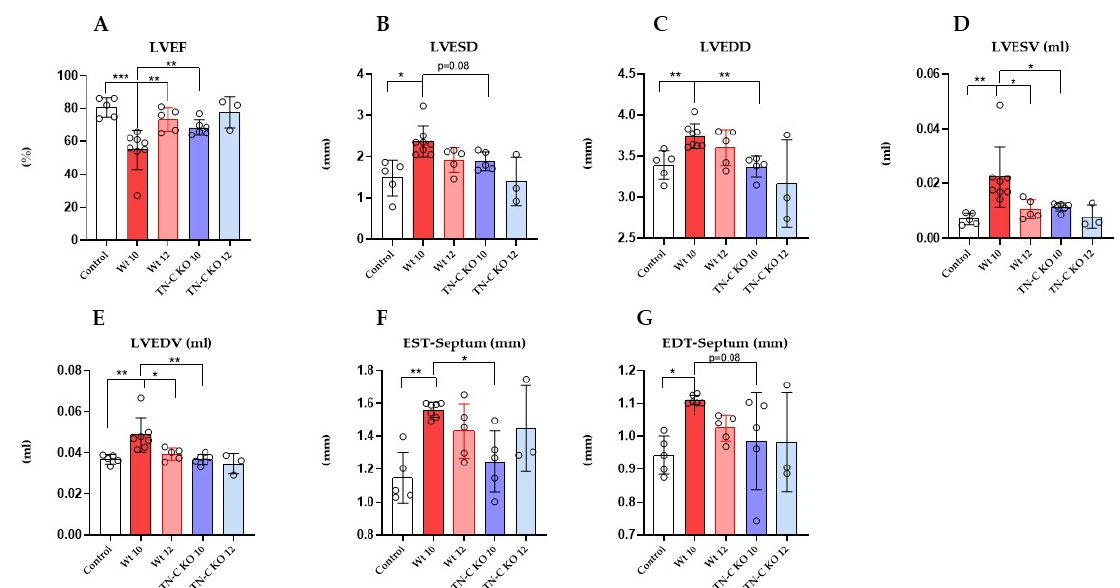
Figure 2. ( A ) Left ventricular ejection fraction (LVEF). ( B ) Left ventricular end-systolic dimension (LVESD). ( C ) Left ventricular end-diastolic dimension (LVEDD). ( D ) Left ventricular end-systolic volume (LVESV). ( E ) Left ventricular end- diastolic volume (LVEDV). ( F ) End-systole septum wall thickness (EST). ( G ) End-diastole septum wall thickness (EDT). * p < 0.05, ** p < 0.01, *** p < 0.001; n = 3–8/group.